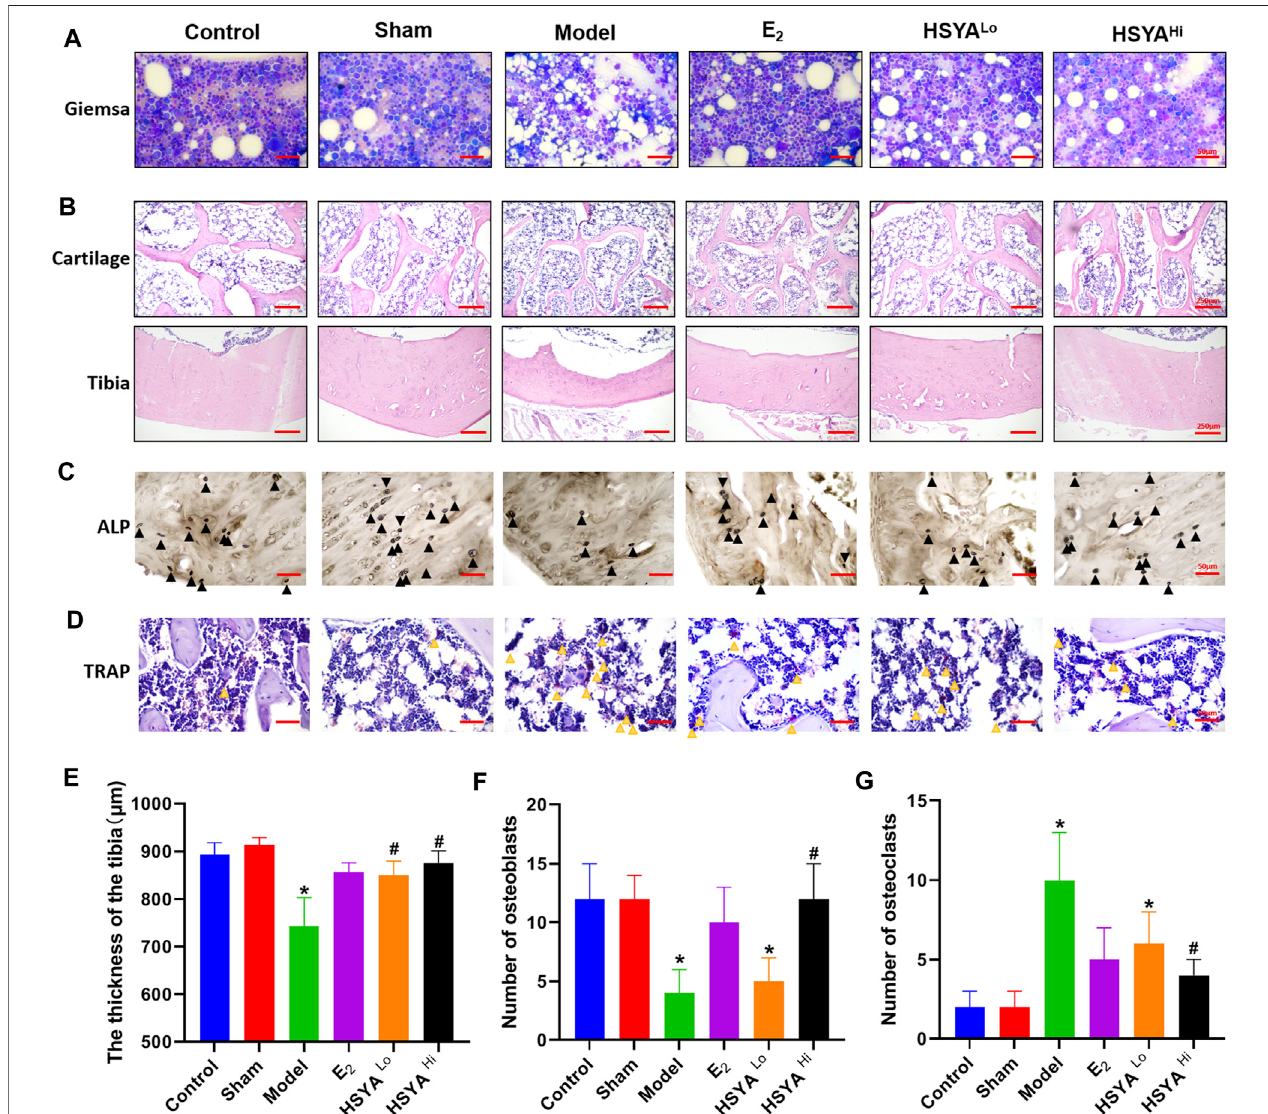
FIGURE4| ProtectionofbonequalitybyHSYAinosteoporoticrats. (A) Giemsastainingofbonemarrowcellsintheleftlegtibiaofrats,thevacuolesinthe fi gureare adipose tissue. (B) HE staining of the proximal femoral cartilage of rats in the upper panel, and HE staining ofthe tibia of rats in the lower panel. (C) alkalinephosphatase stainingofosteoblasts, theblacktrianglesinthe fi gure areosteoclasts. (D) TRAPstainingfor osteoclasts, the yellow triangle inthe fi gureismarkedwithosteoclasts,and the cells are burgundy. (E) the results of tibial bone thickness measurement in the left leg of rats. (F) the statistical graph of osteoblasts number. (G) the statistical graph of osteoclast number. “ * ” indicates p < 0.05, compared with the control group, the difference is statistically The difference is statistically signi fi cant compared with the control group. “ # ” indicates p < 0.05, the difference is statistically signi fi cant in HSYA treatment group compared with the model group.